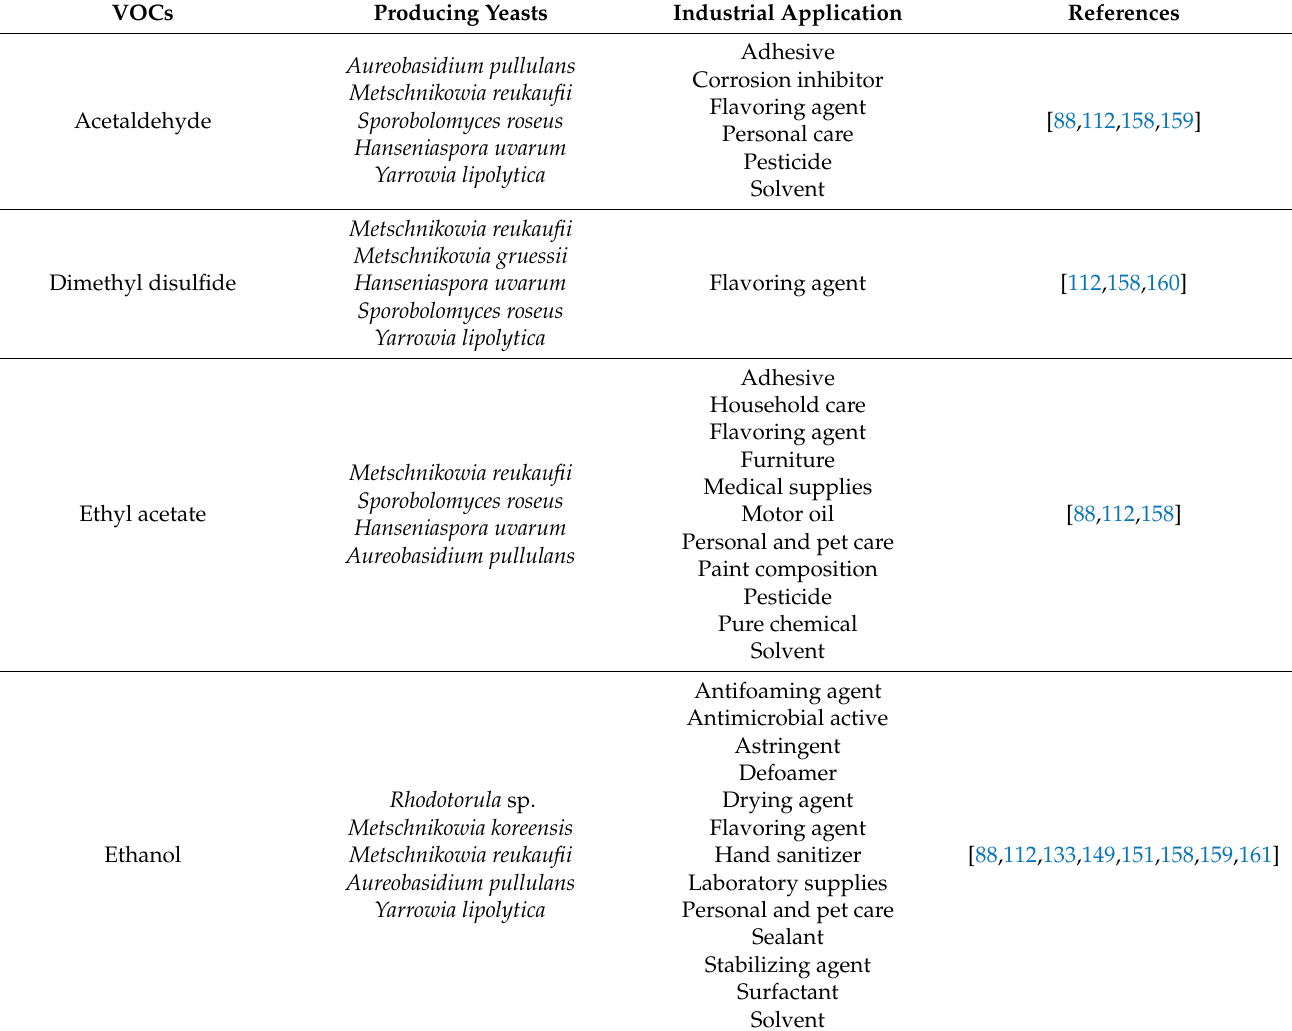
Table 3. Summary of the biotechnological potential of insect–plant-associated yeasts for VOC